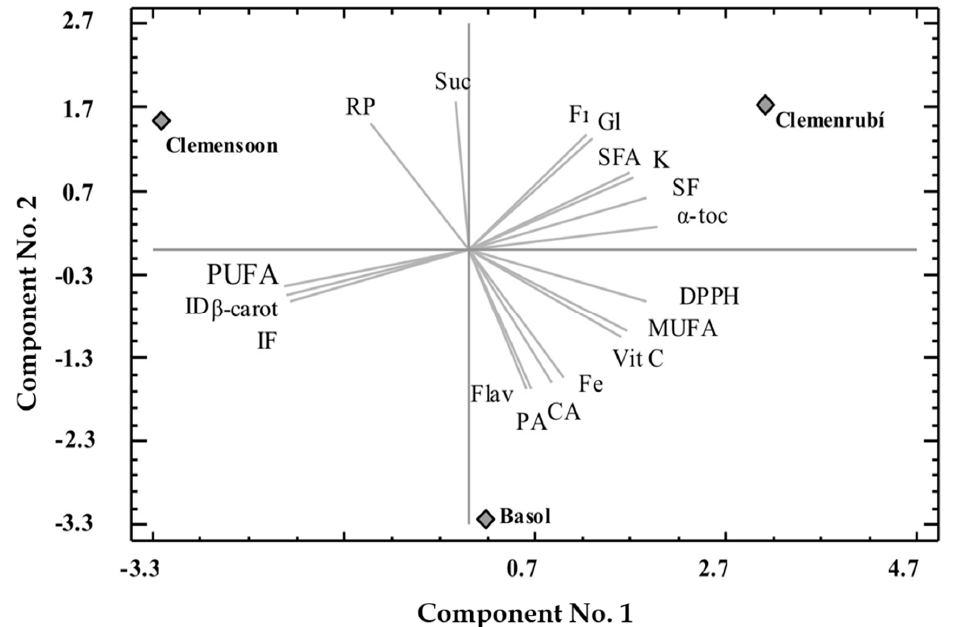
Figure 2. Principal component analysis (PCA) projection of two principal components. Vit C: vitamin